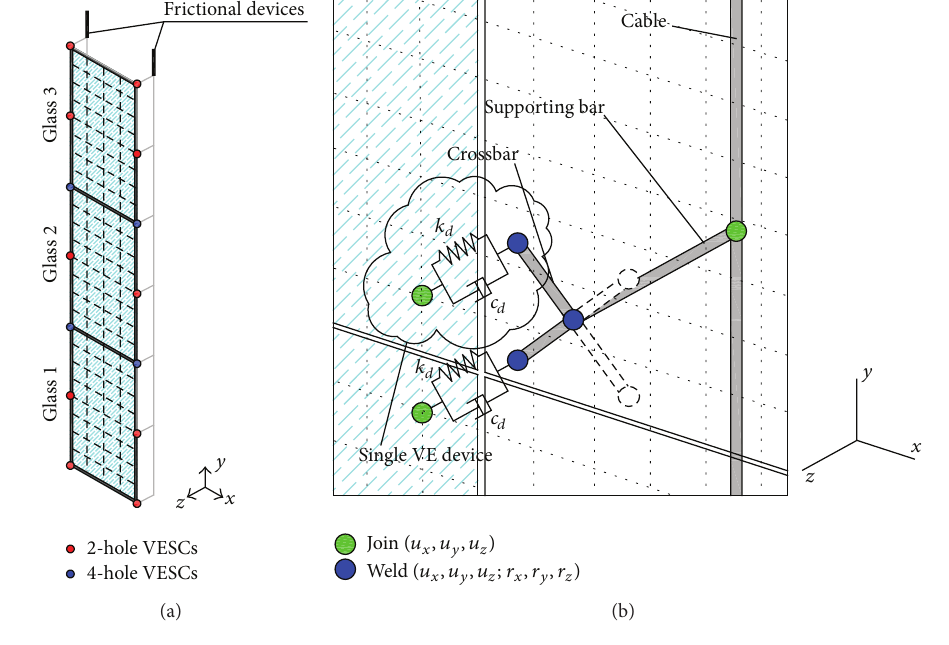
Figure 6: FE-model (a) and detail of half four-hole VESC (ABAQUS) (b). Table 1: Material properties (ABAQUS).